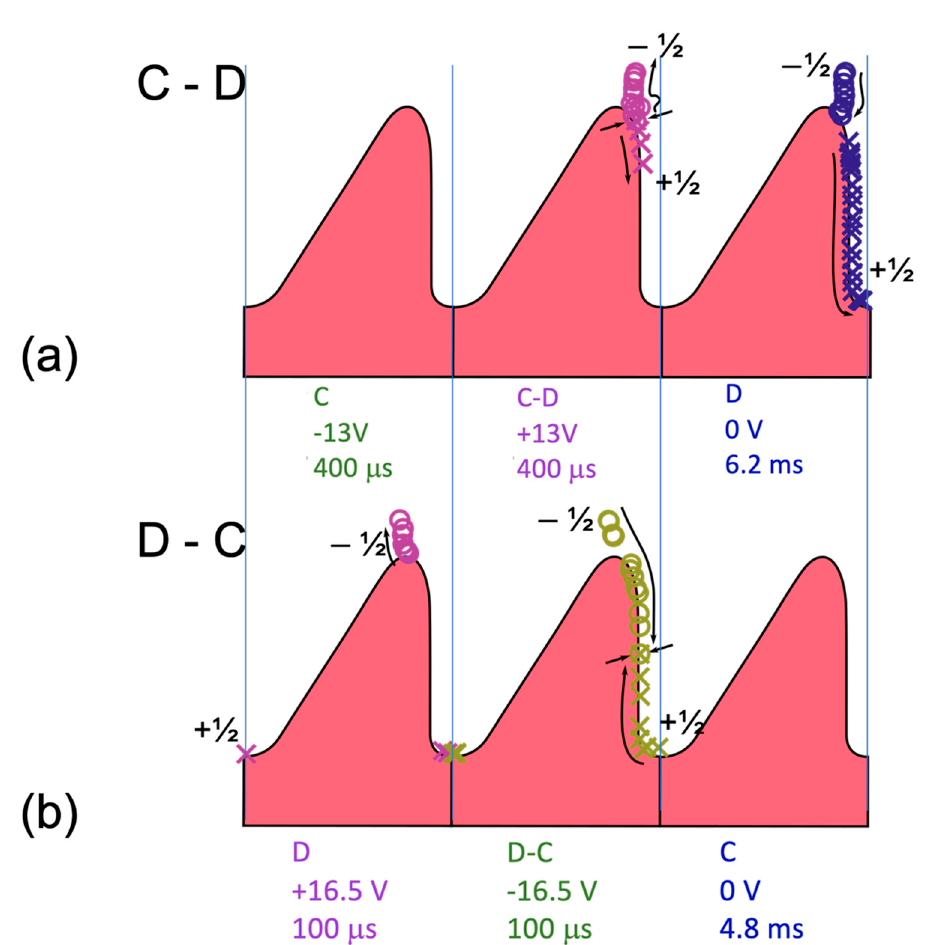
Figure 10. Pictorial summary of the defect dynamics in D-C latching (top) and C-D latching (bottom). Each diagram shows the defect trajectories (if any) during the ( a ) leading (DC balancing) pulse; ( b ) the trailing (latching pulse) pulse application; and C: the 0 V reorientation period. The pulse durations and amplitudes are indicated for each figure. Defect locations are indicated with circles ( − ½ defect) and crosses (+½ defect) and their direction of travel with arrows. The symbol colours indicate whether the field is positive (purple), negative (lime) or zero (blue). Pinched arrows indicate the location of defect annihilation. Note, in the D-C latching most of the defect movement occurs during the applied pulses, whereas for the C-D latching there is significant reorientation of the director, and hence defect positions, after the pulse has ended but before the defects settle onto the grating surface.